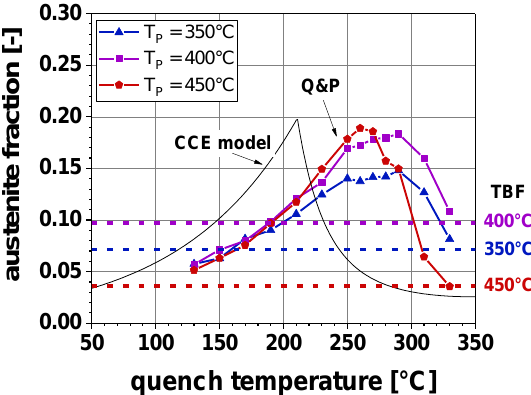
Figure 8. Retained austenite (RA) content as a function of T Q for a T P ( T B ) of 350, 400, and 450 °C. Figure 9 represents microstructure charts, where the phase fractions are plotted as a function of T Q for different T P . In addition, the bar charts, situated close to the right rim of each diagram, depict